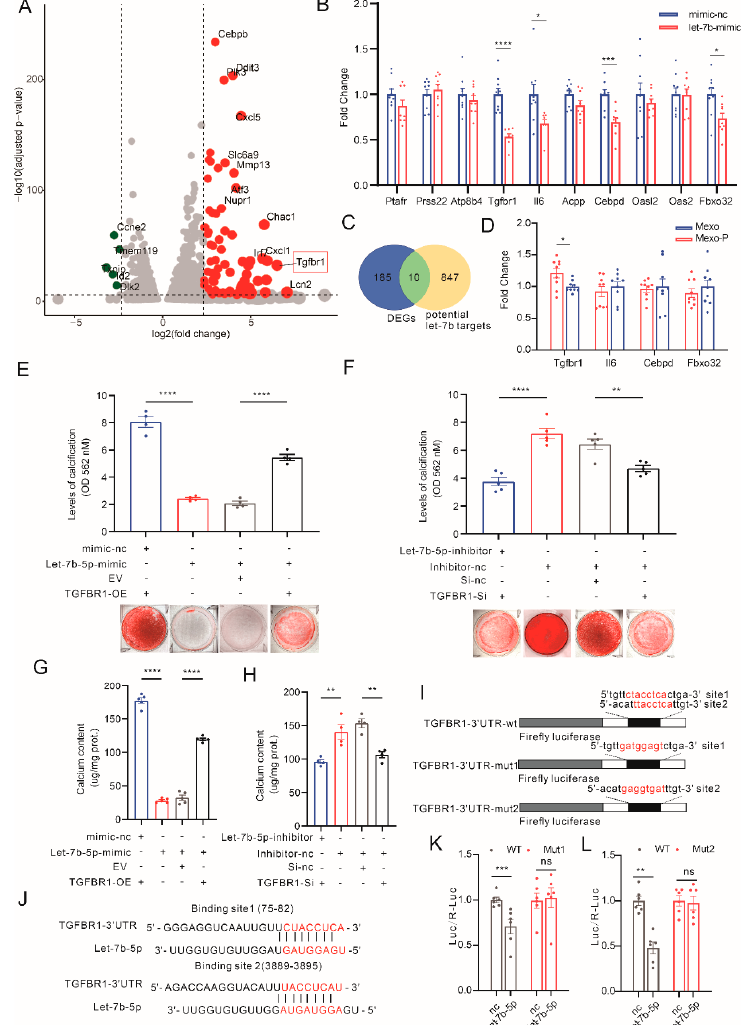
Figure 4. Let-7b-5p mitigates vascular calcification by regulating TGFBR1. ( A ) Volcano plots showing differentially regulated genes (DEGs) in RNA-seq of Mexo- and Mexo-P-treated MOVAS. ( B ) Venn diagram showing the intersection of miRBD-predicted potential let-7b-5p targets and DEGs. ( C ) mRNA levels of 10 potential target genes were detected by qRT-PCR in let-7b-5p-mimic- or mimic-nc-treated HASMCs (unpaired t -test, n > 3). ( D ) Transcription levels of four significantly regulated genes in ( C ) were detected in Mexo- or Mexo-P-treated HASMC (unpaired t -test, n > 3). ( E ) Representative images of ARS staining (bottom) and ARS quantification (top) of HASMCs, in which TGFBR1 and let-7b-5p levels were manipulated with TGFBR1 overexpression plas- mid (TGFBR1-OE) or let-7b-5p-mimic treatment in calcifying medium (one-way ANOVA, n = 4). ( F ) Representative images of ARS staining (bottom) and ARS quantification (top) of HASMCs, in which TGFBR1 and let-7b-5p levels were manipulated with TGFBR1-si or let-7b-5p-mimic treatment in calcifying medium (one-way ANOVA, n = 4). Calcium content of HASMCs with altered TGFBR1 levels with TGFBR1-OE ( G ) or TGFBR1-si ( H ), with or without the treatment of let-7b-5p-mimic or let-7b-5p-inhibitor in calcifying medium (one-way ANOVA, n = 4). ( I ) Tergetscan database predicted binding sequences of let-7b-5p on TGFBR1-3 (cid:48) UTR. ( J ) Wildtype (wt) and two mutations (mut1 and mut2) of TGFBR1-3 (cid:48) UTR were inserted into luciferase vectors. Luciferase activity assay of HASMCs co-transfected with vectors carrying wt or mutated TGFBR1-3 (cid:48) UTR (mut1, ( K ), mut2, ( L )), renilla vectors, mimic-nc, or let-7b-5p-mimic for 6 h, medium change, and cultured for another 48 h before assay (two-way ANOVA, n > 3). * p < 0.05, ** p < 0.01, *** p < 0.001, **** p < 0.0001, n.s. not